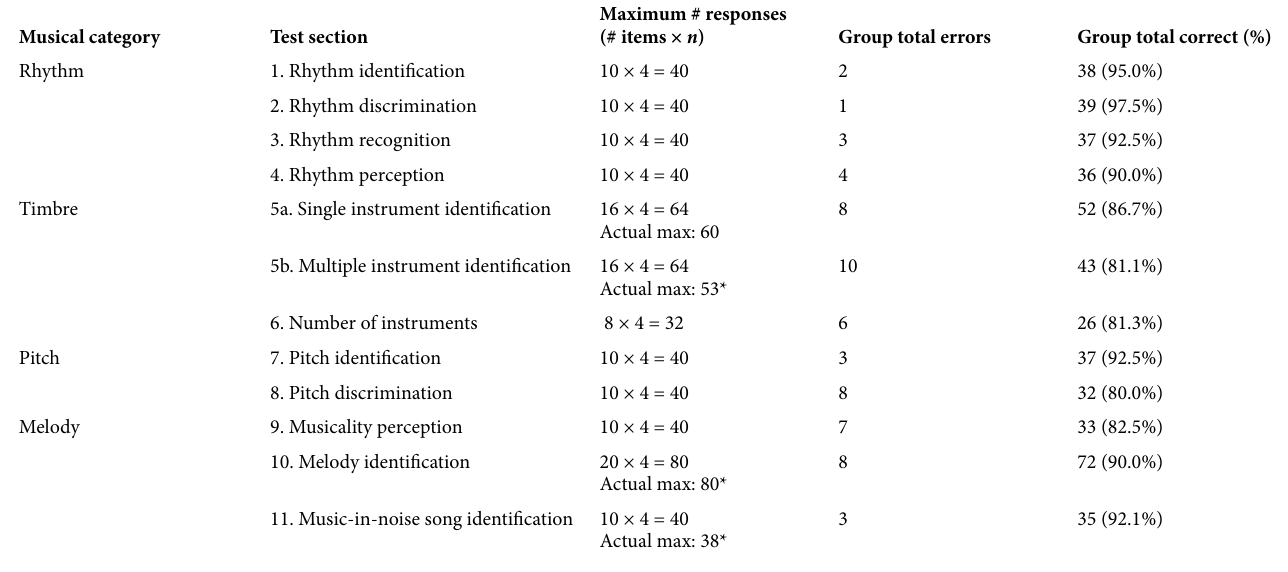
Table VII. Error rates and percentage correct for the adapted version of the MPT presented to normal hearing listeners ( n =4) Musical